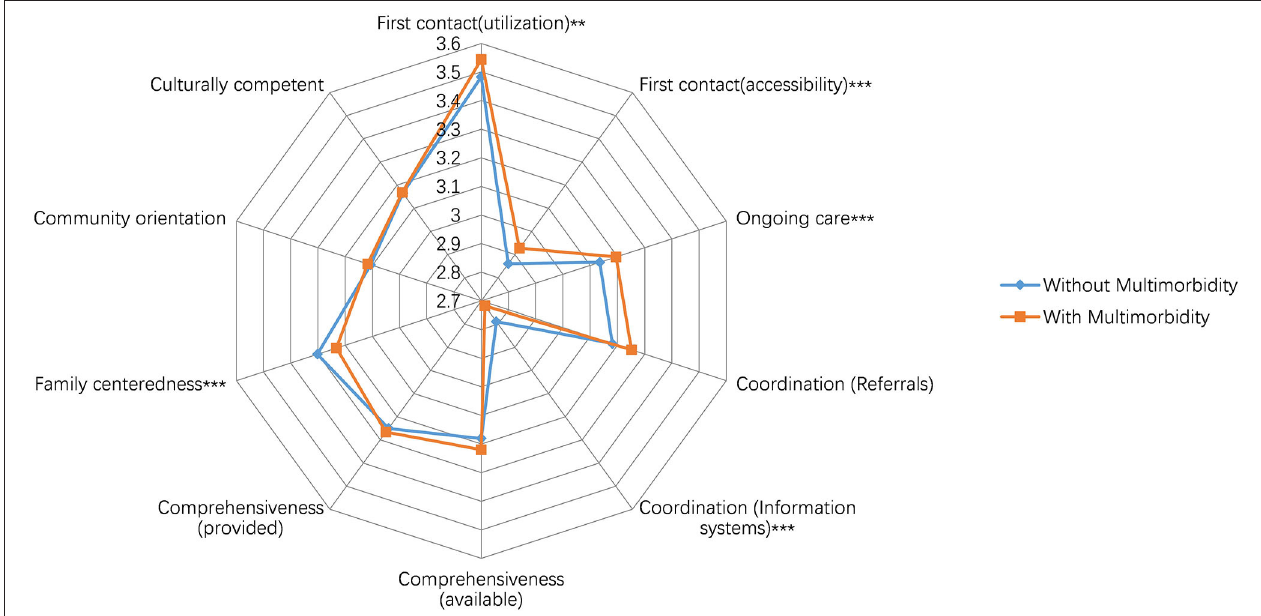
FIGURE 1 | Scores of primary care attributes reported by participants with and without